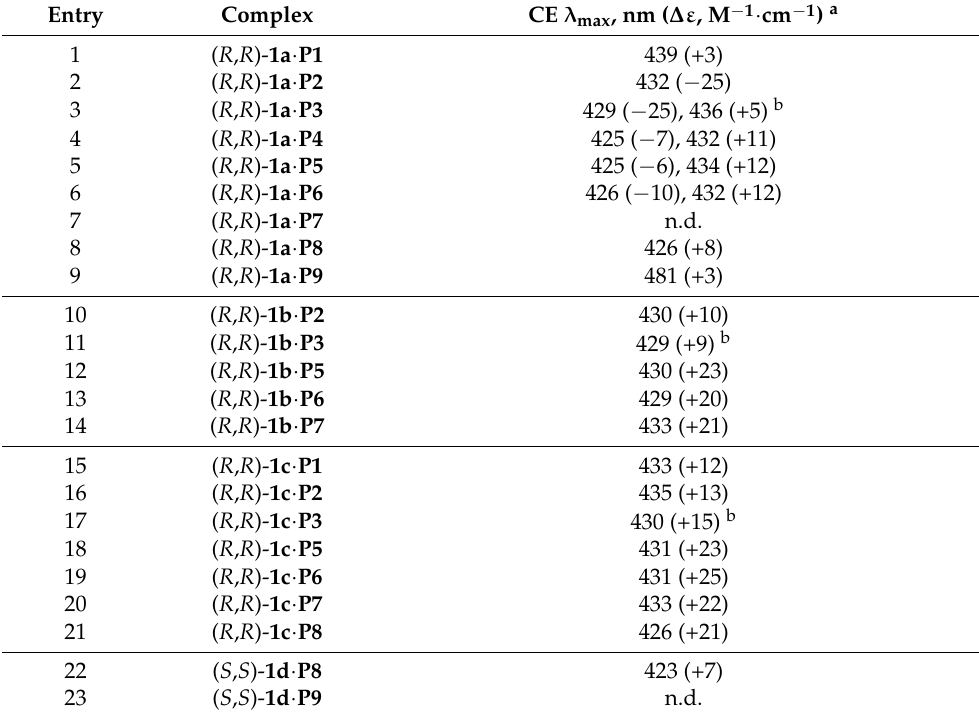
Table 3. CD data for the complexes of zinc porphyrins P1 – P9 with thioureas 1a – d measured in CH 2 Cl 2 .